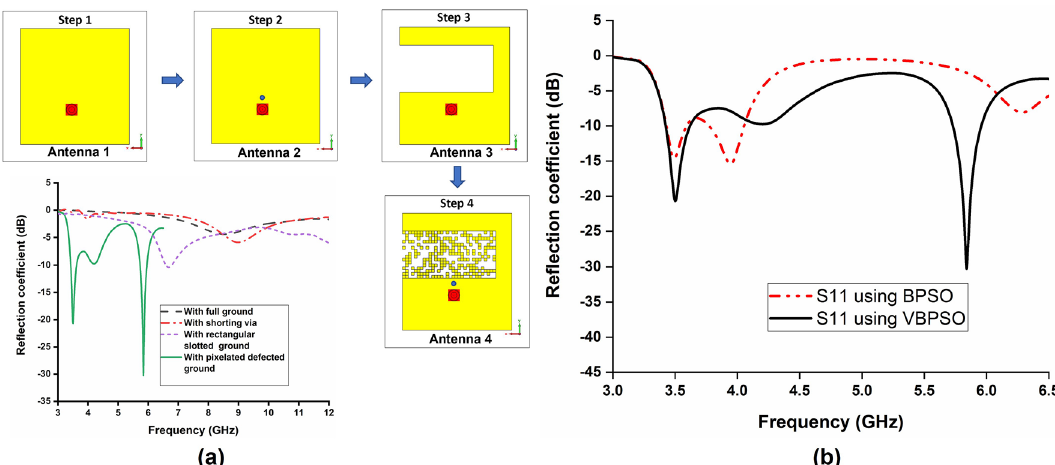
Figure 12. ( a ) Evolution of the antenna; Antenna 1-with full ground and patch, Antenna 2-with shorting via, Antenna 3-with rectangular slotted ground, Antenna 4-with pixelated defected ground, Software used: CST Microwave Studio 2019 ( b ) Simulated reflection coefficient of the antenna with VBPSO vs. BPSO.